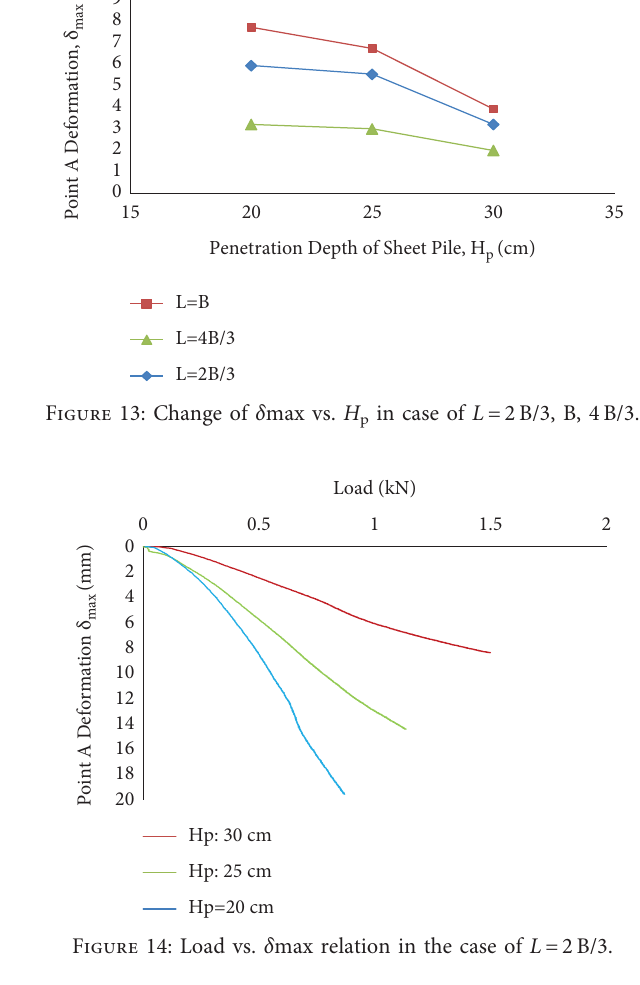
Figure 14: Load vs. δ max relation in the case of L � 2B/3.